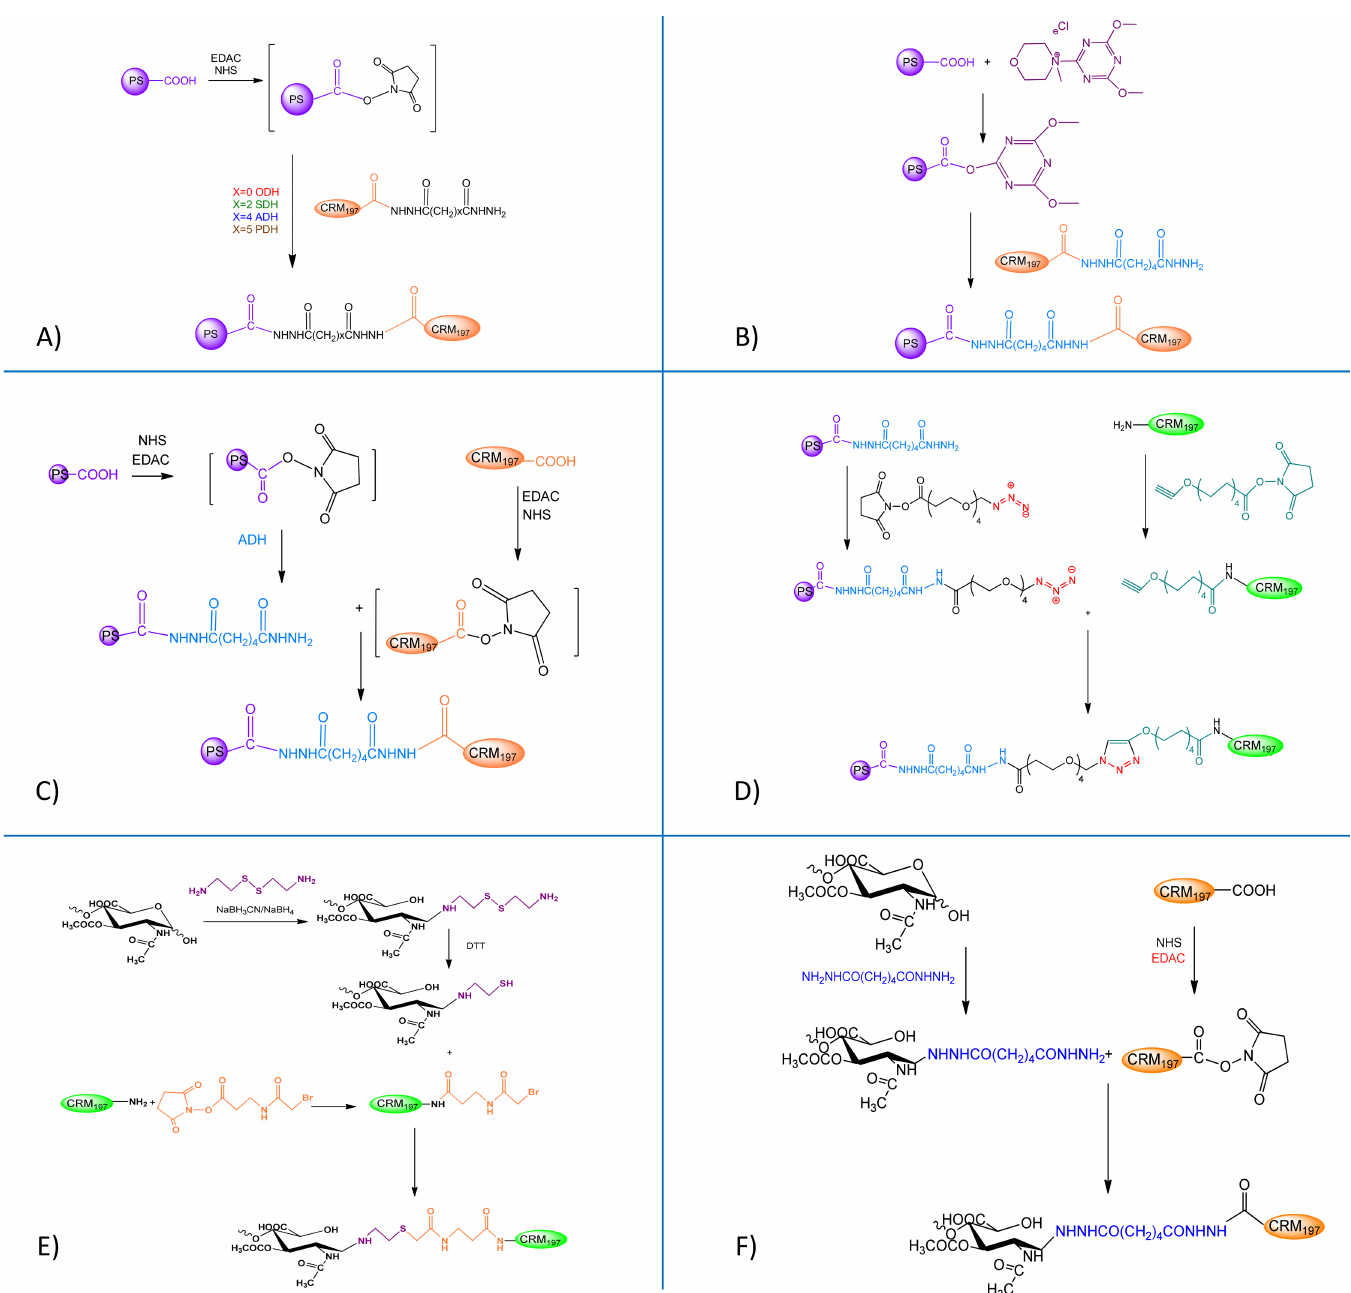
Fig 5. Conjugation scheme for the synthesis of A) fVi-CRM 197 conjugates differing for the length of the spacer moleculeintroduced on CRM 197 before conjugationto fVi; B) fVi(DMT-MM)CRMADH; C) fVi(ADH)-CRM 197 ; D) fViADHN 3 -CRMalkyne; E) fVis(ADH)-CRM 197 ; F) fVisSH-CRMSBAP (Table